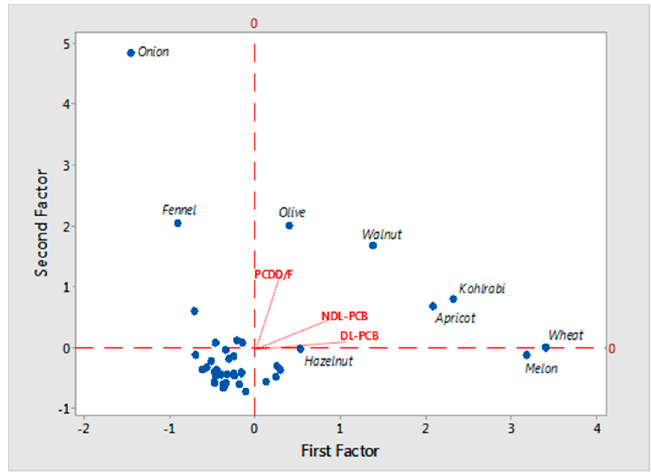
Figure 3. Biplot of PC1 and PC2 for PCDD/Fs, DL-PCBs, and NDL-PCBs in all samples.